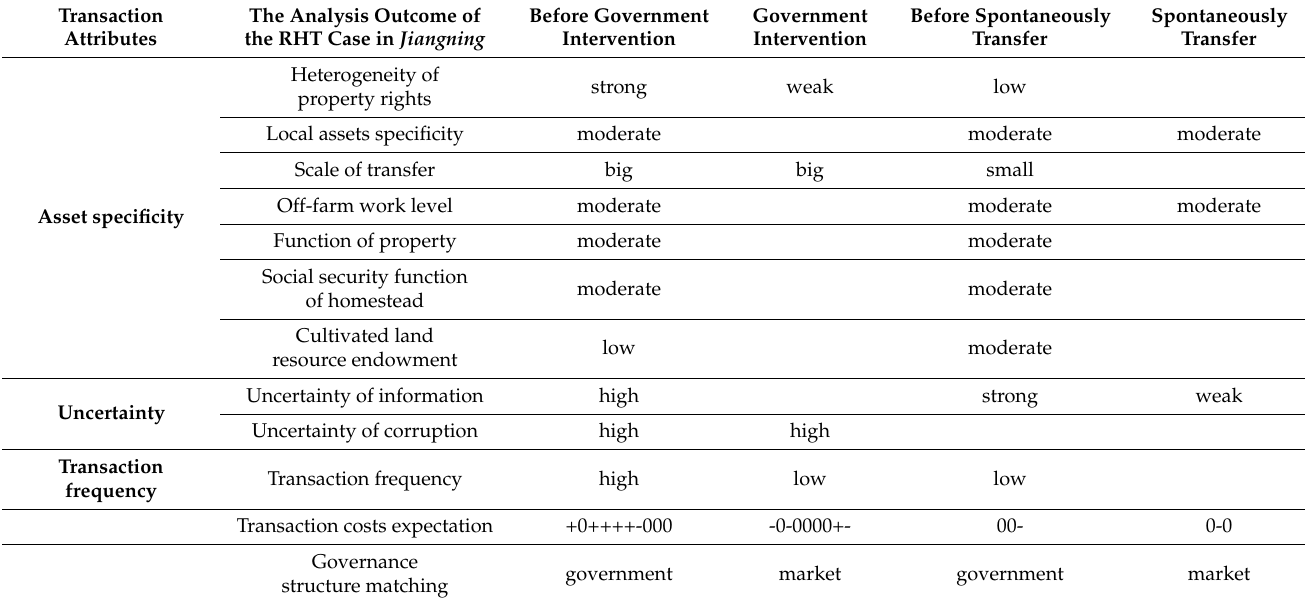
Table A6. The transaction attributes and the appropriate governance structures in Jiangning